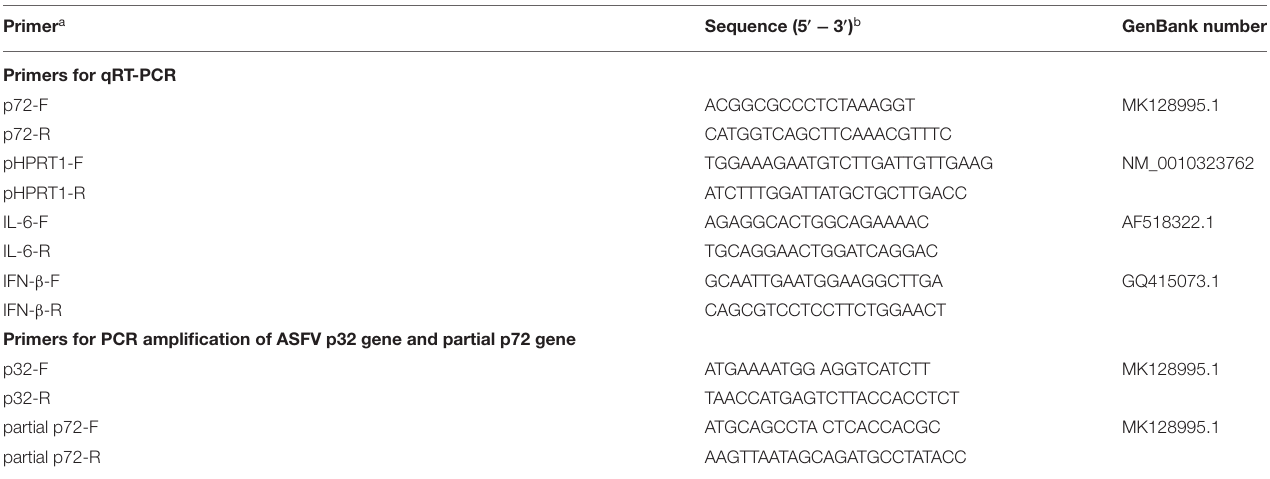
TABLE 1 | List of primers used in this